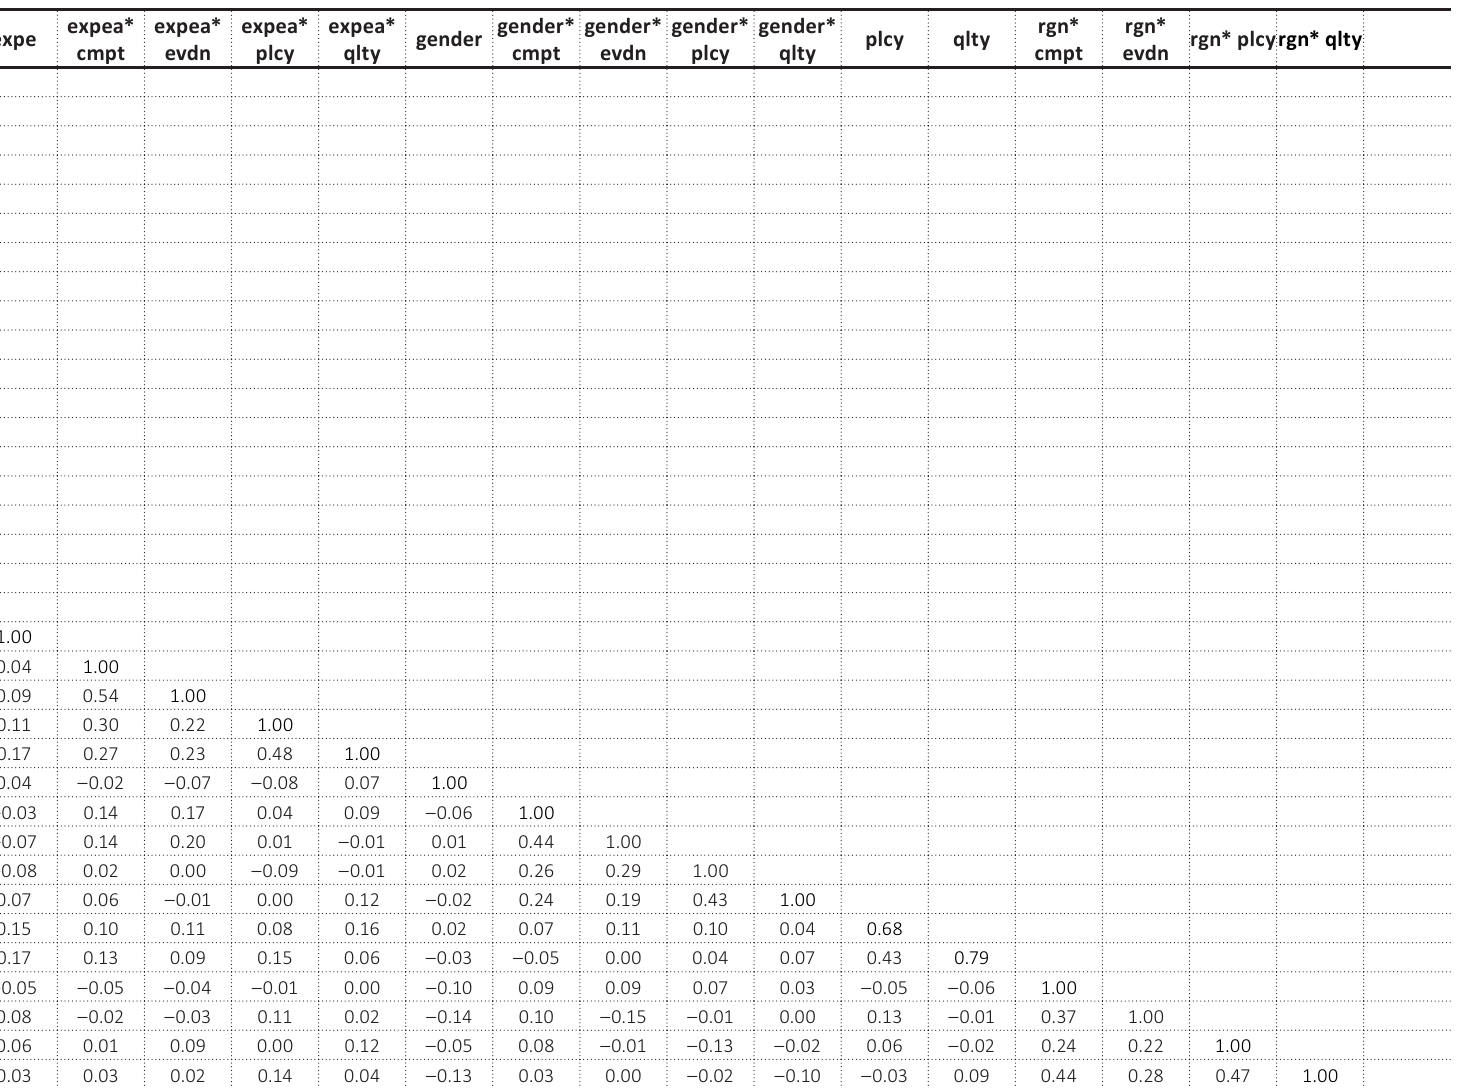
Table A1 (cont.). Discriminant validity